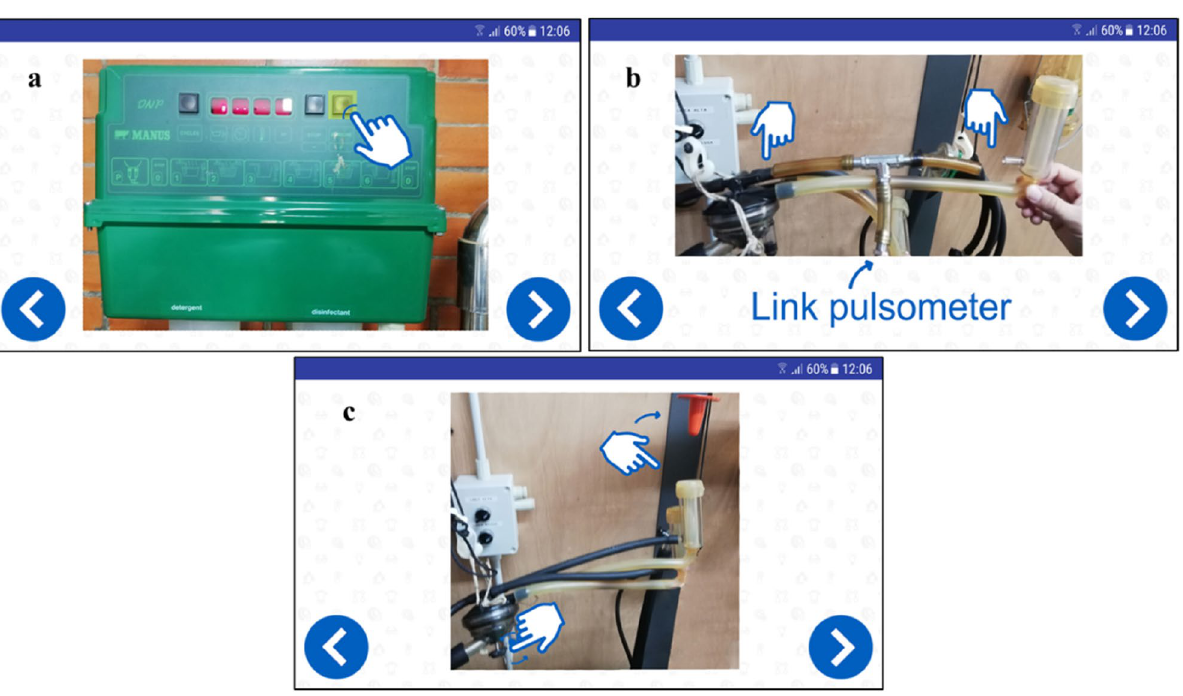
Figure 6. Example of augmented information visualized on the smart glasses M400 during the mechanical milking machine test through the BStep app. ( a ) Indications for vacuum pump ignition, ( b ) indication for the sensor attachment (T connection); ( c ) setting the milking machine in simulated milking (moving the claw valve and closing the liner with the specific